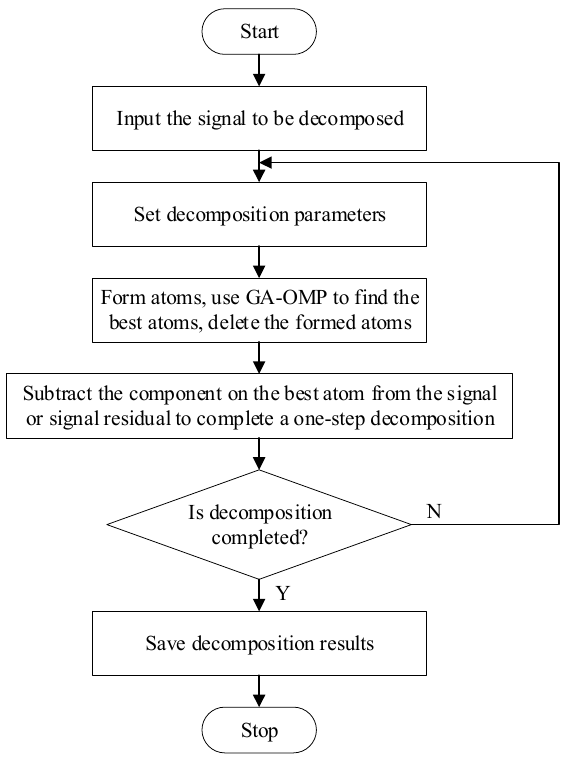
Figure 4. Process of sparse decomposition by using GA-OMP.